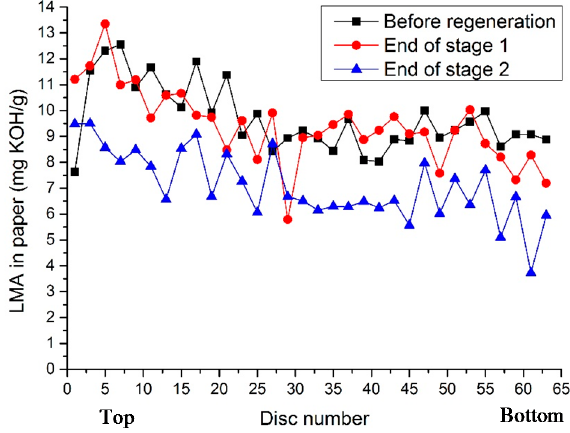
Figure 9. Profile of LMA in paper before regeneration, at the end of stage 1, and the end of stage 2.